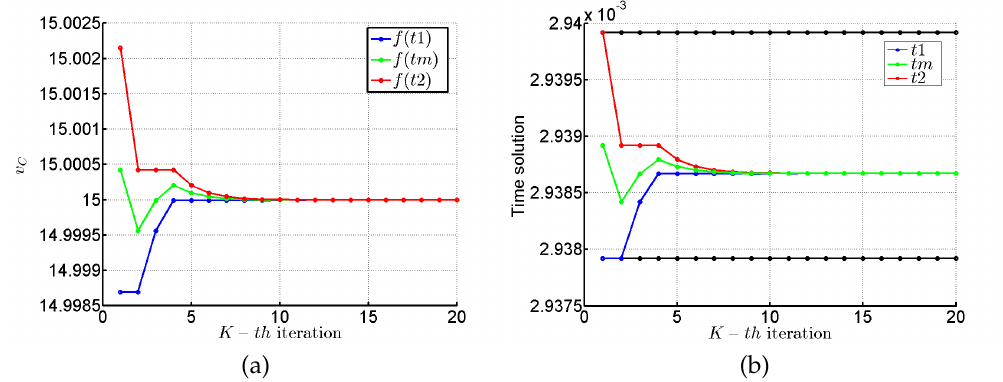
Figure 6. Bisection numerical method results: one example to show evolution and convergence of numerical solution: ( a ) boltage value convergence to v C = 15 and ( b ) time solution evolution.